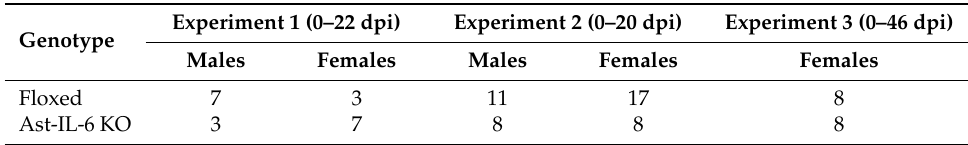
Table 1. Number of mice per genotype, sex and